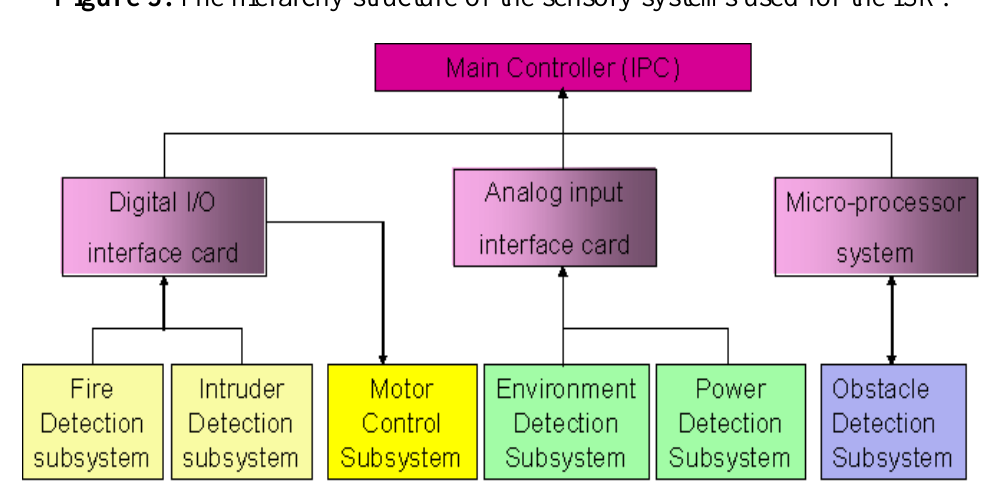
Figure 5. The hierarchy structure of the sensory systems used for the